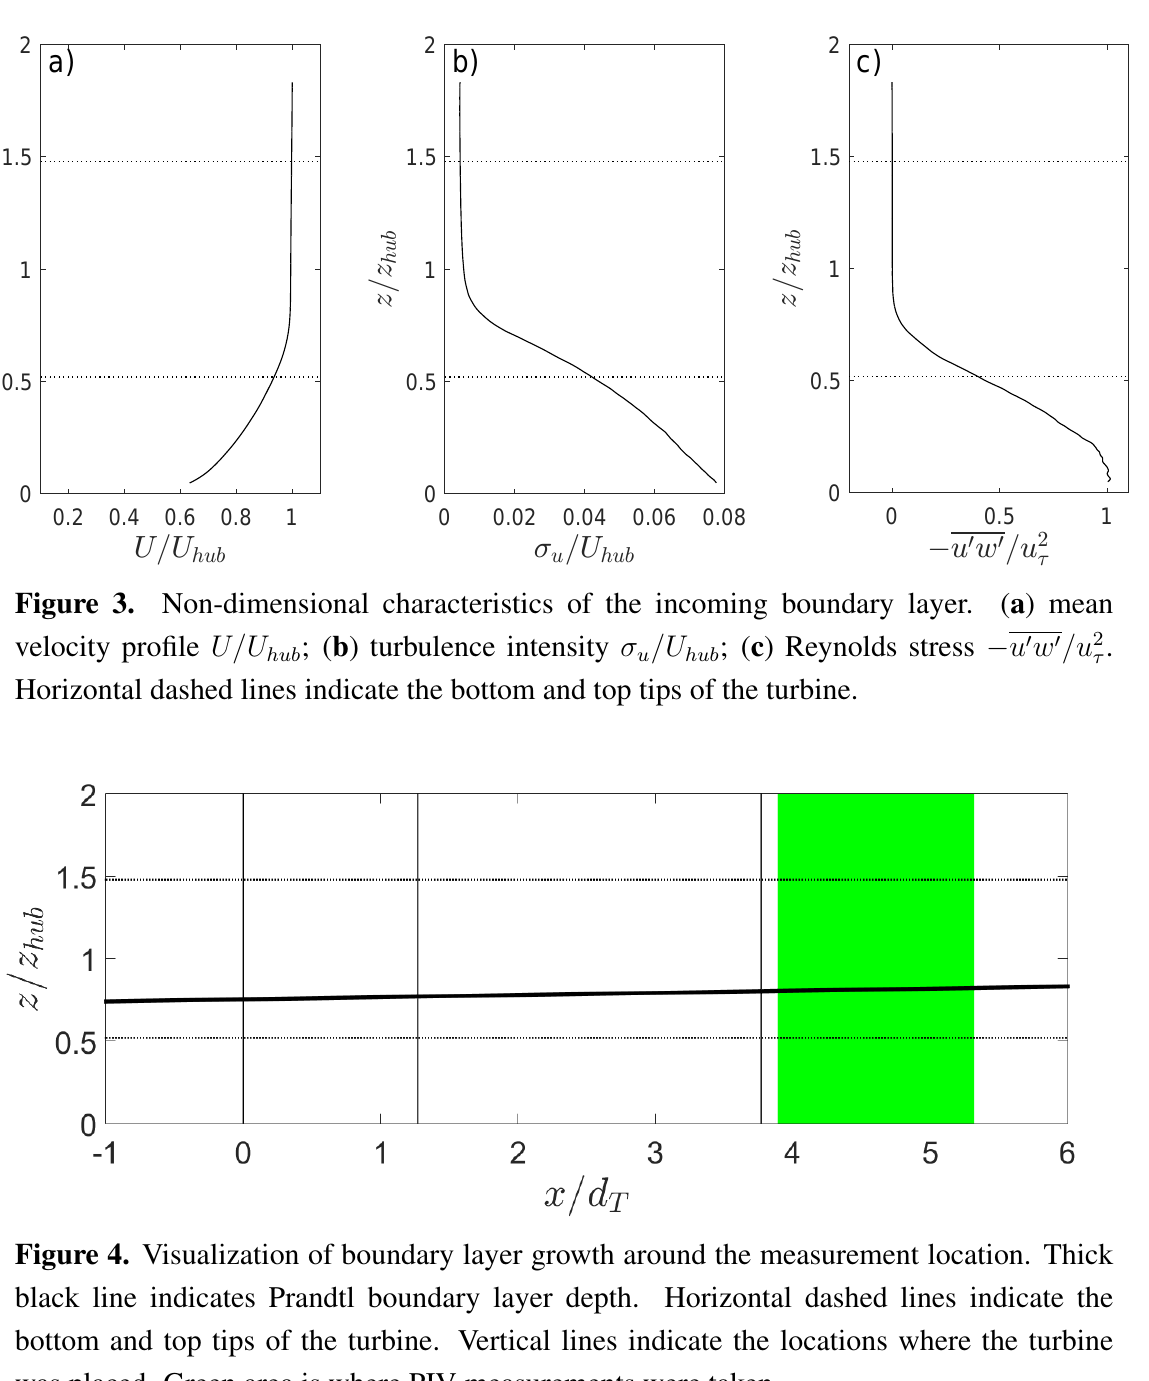
Figure 4. Visualization of boundary layer growth around the measurement location. Thick black line indicates Prandtl boundary layer depth. Horizontal dashed lines indicate the bottom and top tips of the turbine. Vertical lines indicate the locations where the turbine was placed. Green area is where PIV measurements were